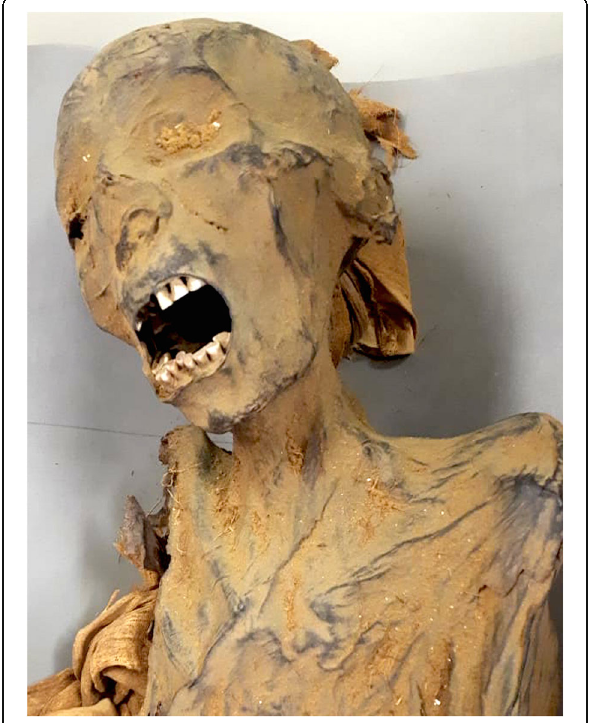
Fig. 1 Picture of the head and upper torso of mummy “ Unknown- Woman-A. ” The picture was taken on March 9th, 2020. It shows widely opened mouth and tilted head of the mummy to the right